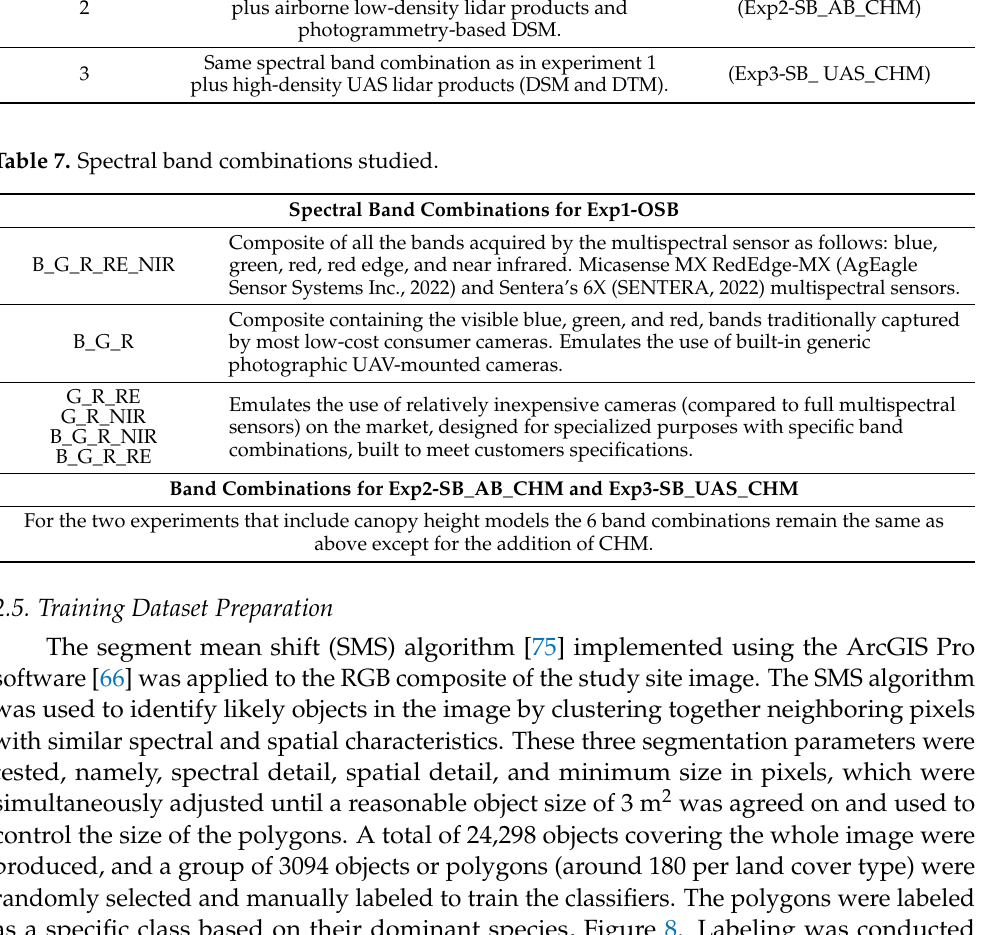
Table 6. Experiments, description. Experiment Same spectral band combinations as in experiment 1 plus airborne low-density lidar products and photogrammetry-based DSM.